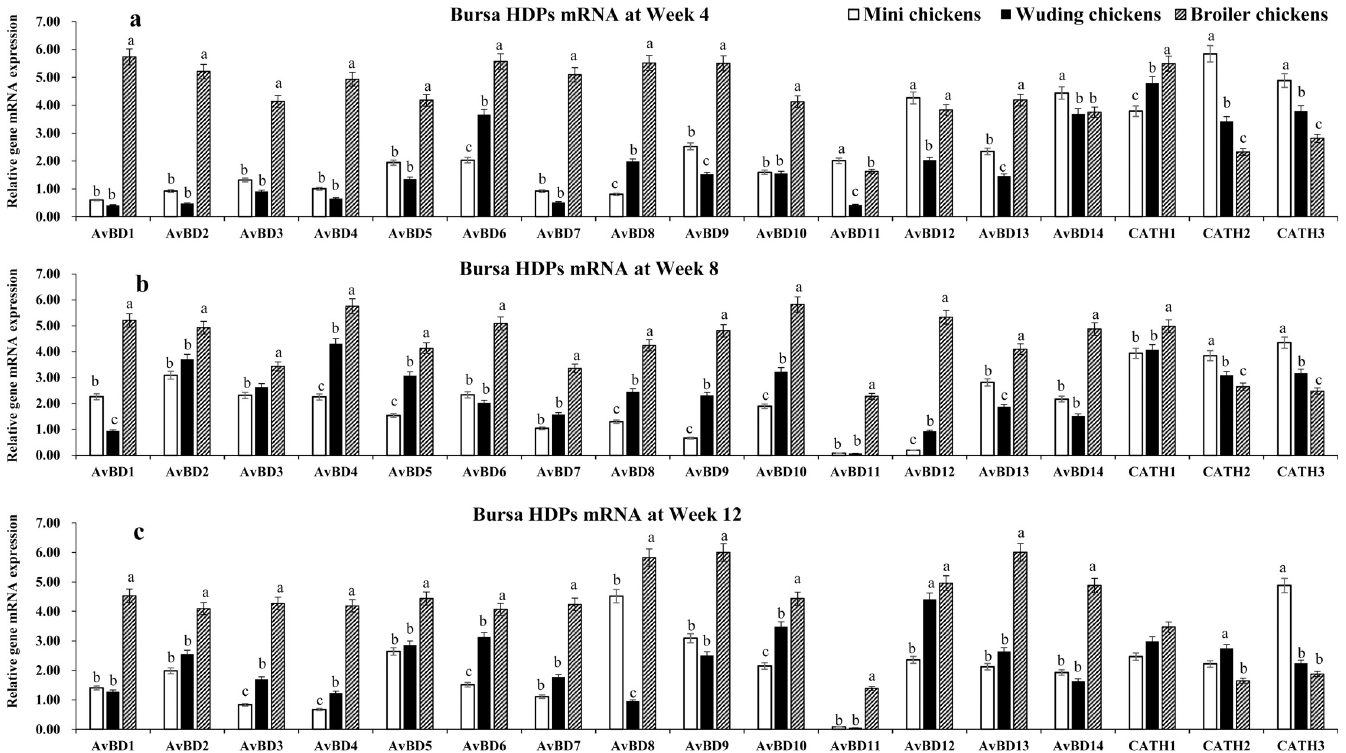
Fig 5. HDP mRNA expression in the bursa of Fabricius. Comparison analysis of mRNA expression of AvBD 1–14 and CATH 1–3 genes in the bursa of Fabricius of three chickens at weeks 4 (a), 8 (b), and 12 (c). Twenty chickens per type per time point were used and gene expression was investigated with RT-qPCR. The experiment was repeated three times. Data are expressed as the mean ± SEM at each age for each chicken and different letters on top of each bar represent significant differences (p < 0.05) among chickens.